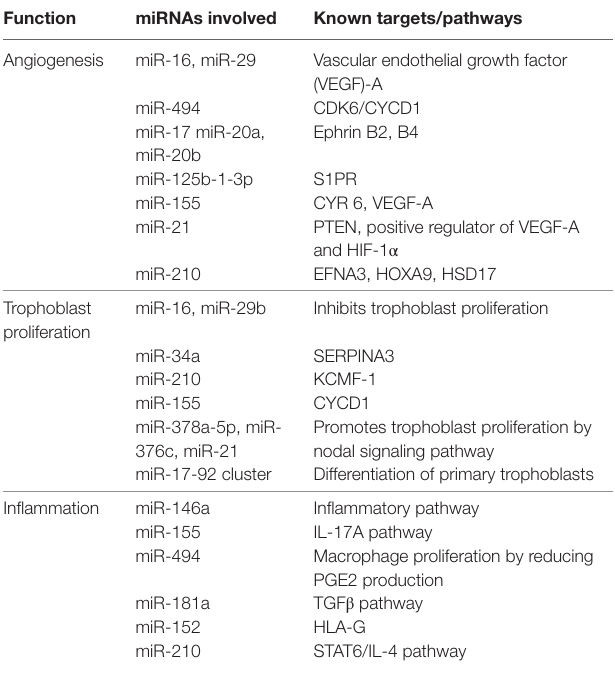
TABLe 1 | A list of placenta-associated microRNAs (miRNAs) involved in preeclampsia (PE). Function miRNAs